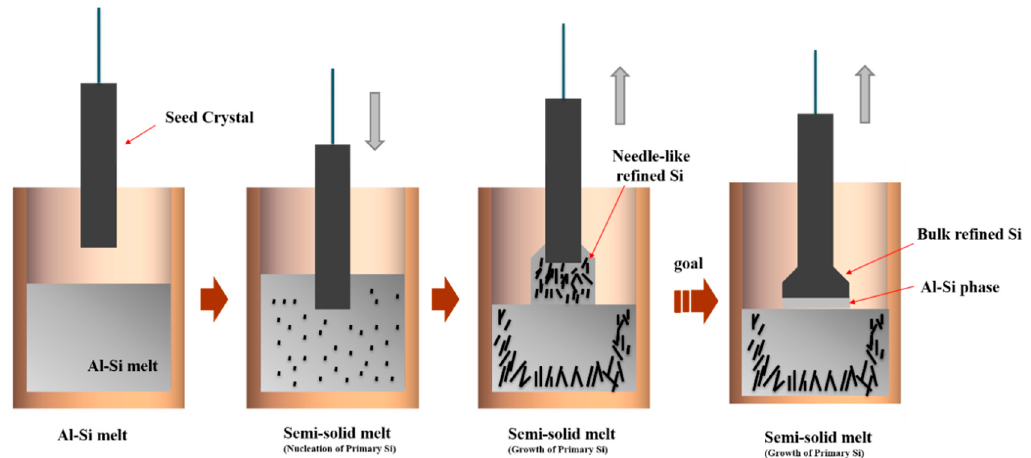
Figure 8. Diagrammatic drawing of the growth of refined silicon during the Czochralski process.